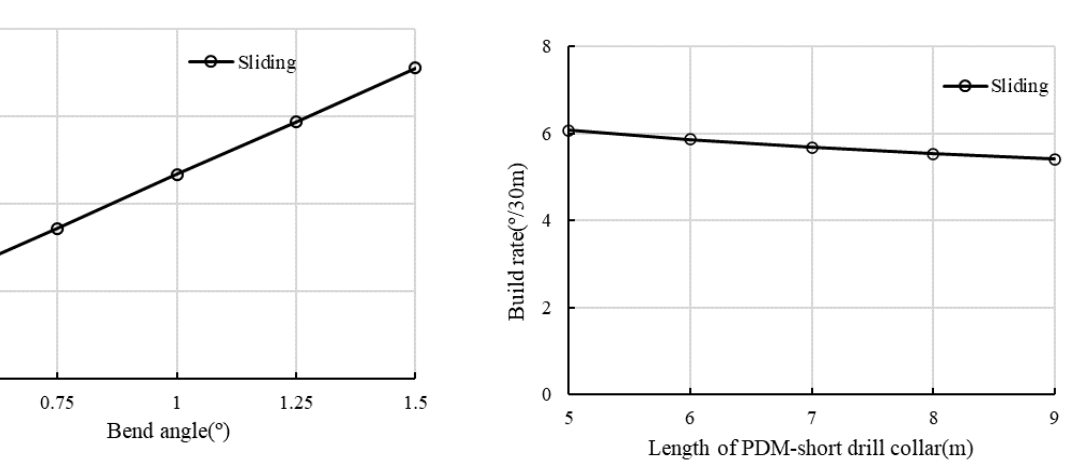
Fig. 18. Sliding build rate VS bend angle